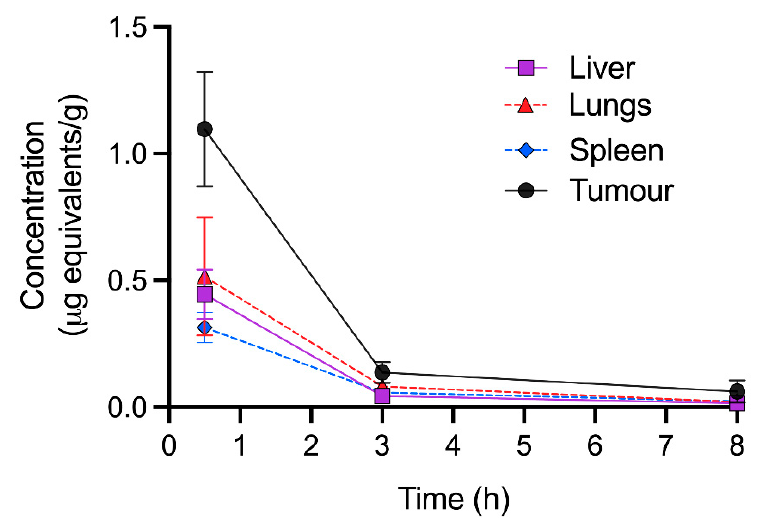
Figure 3. Quantitative radioactivity analysis of perfused tissues at 0.5–8 h following intravenous administration of 5 mg/kg of [ 3 H]-CEND-1 in female BALB/c mice with 4T1 cell tumours. The data show the mean ± SD of 5 mice per timepoint.